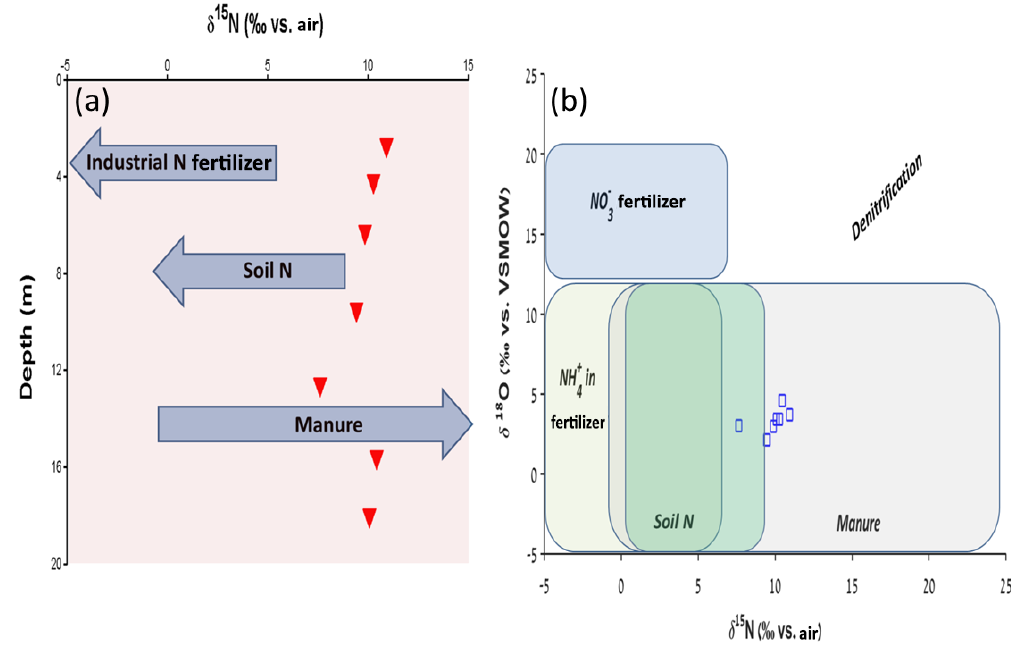
Figure 4. δ 15 N profile of nitrate in the water samples obtained from the vadose zone under the crop field.